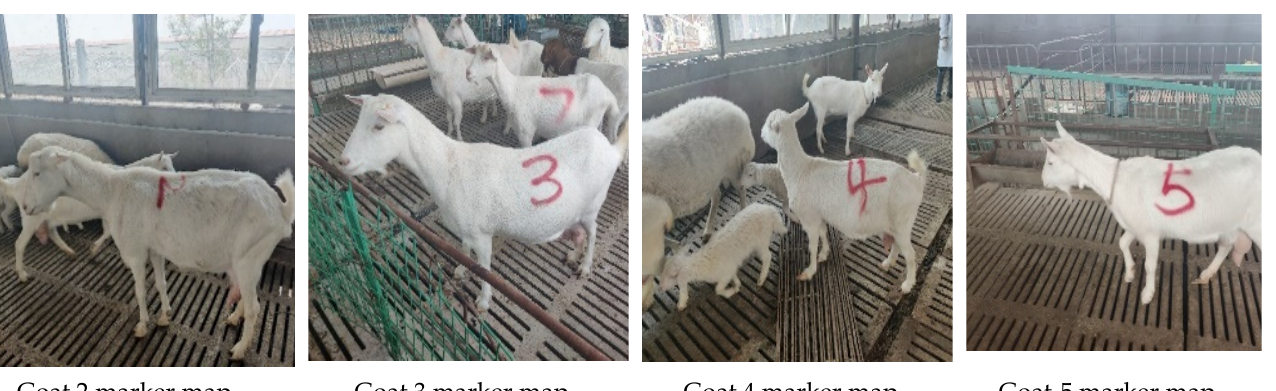
Figure 1. Schematic diagram of milk-goat marking.